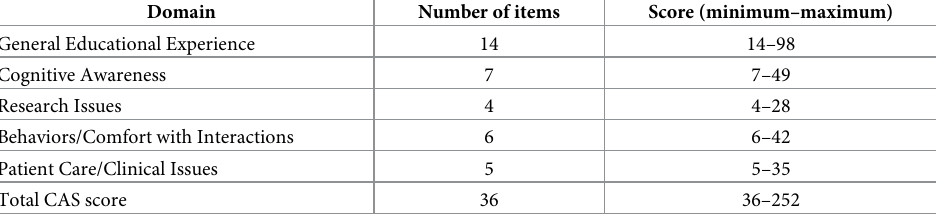
Table 2. Cultural Awareness Scale (CAS) domains scoring